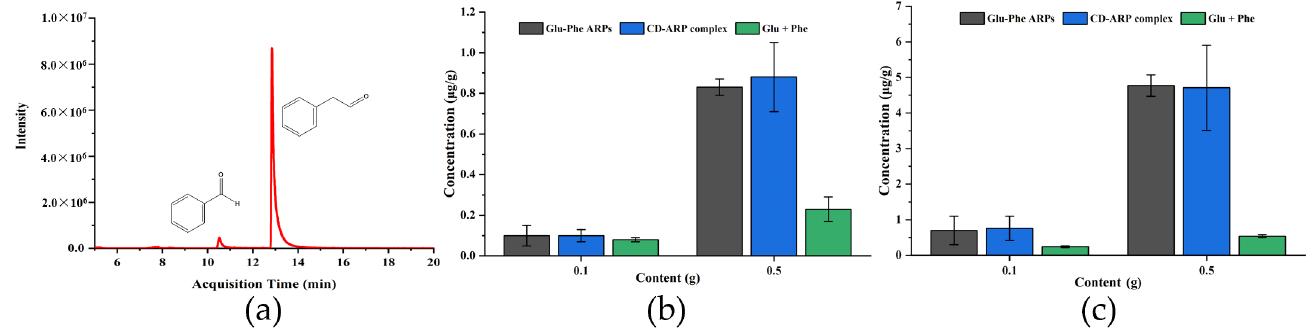
Figure 6. ( a ) Extracted ion chromatogram of cookies with CD-ARP complex (0.5 g). The benzaldehyde ( b ) and phenylacetaldehyde ( c ) concentrations of cookies with Glu-Phe ARPs, CD-ARP complex and Glu + Phe. Content is the mass of the added or theoretically generated Glu-Phe ARPs.